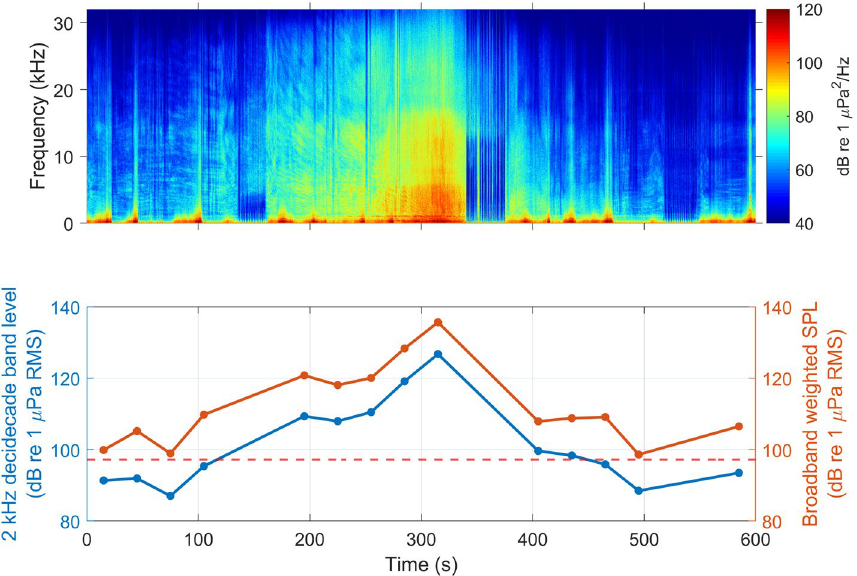
Figure 4. Vessel pass with the highest maximum 2 kHz decidecade received level in the study. The top image shows a spectrogram of the power spectral density (PSD, i.e., power per 1 Hz band). The vessel noise in the recording is interrupted multiple times due to surfacing of the seal. The bottom image shows the corresponding 2 kHz decidecade band levels (blue line), computed as 30 s averages as described in the text, as well as broadband weighted sound pressure levels (SPL; orange line) from 500 Hz to 20 kHz following the frequency weighting for phocid seals in water (PCW) by Southall et al. 37 . The red dashed line illustrates the 97 dB detection threshold used to detect high noise events in the 2 kHz decidecade band.